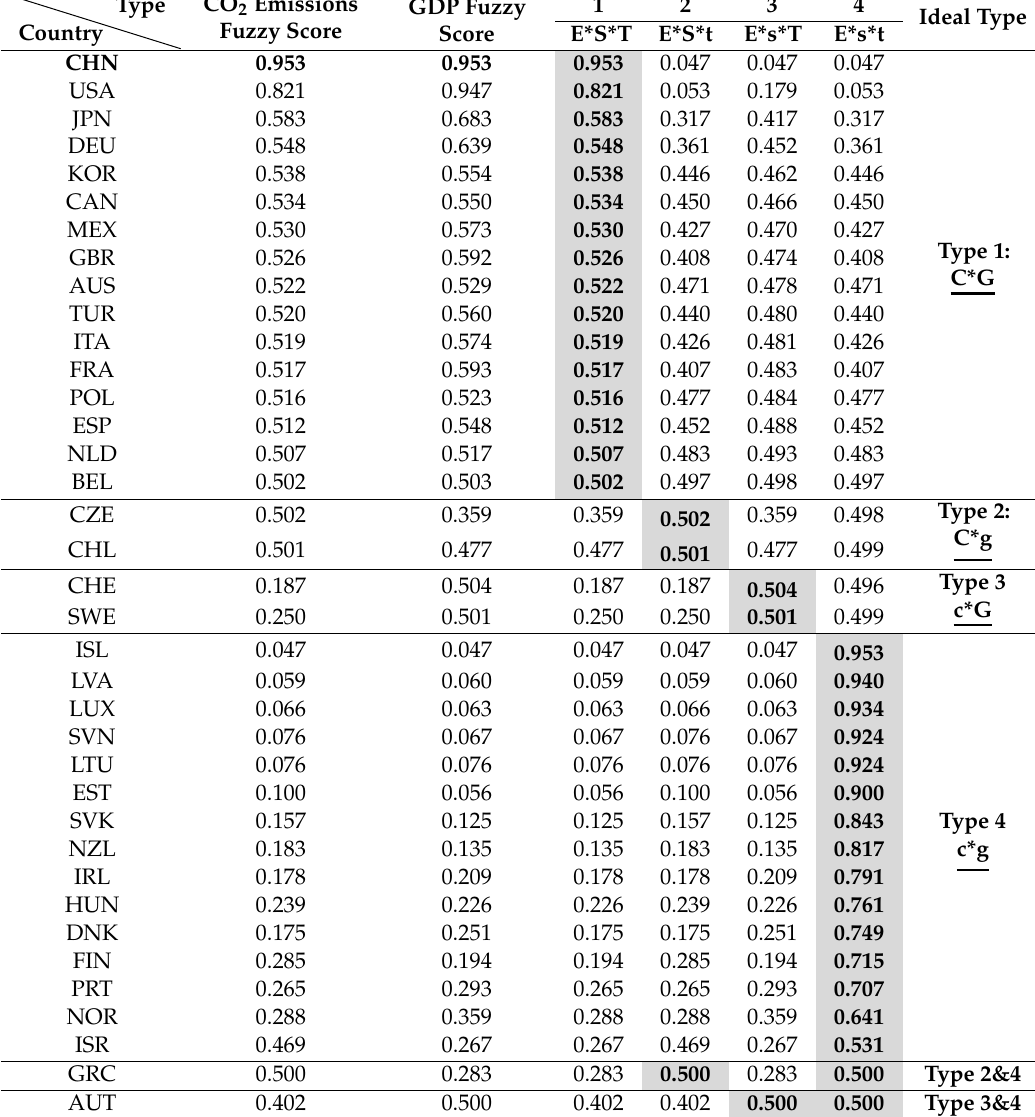
Table 5. Results of Fuzzy-set Ideal Type Analysis